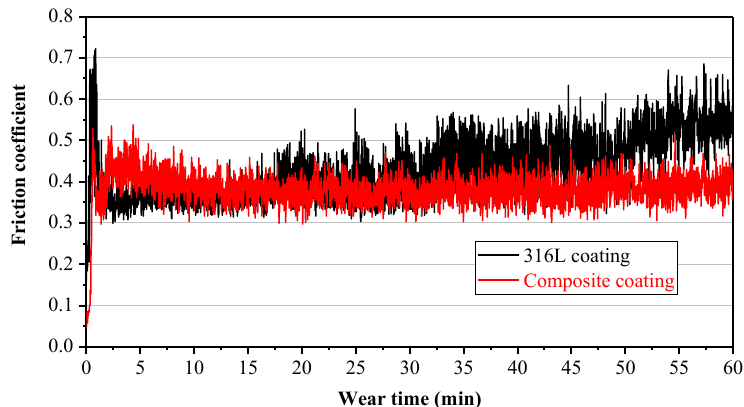
Figure 6. Friction coefficient of 316L coating and composite coating.